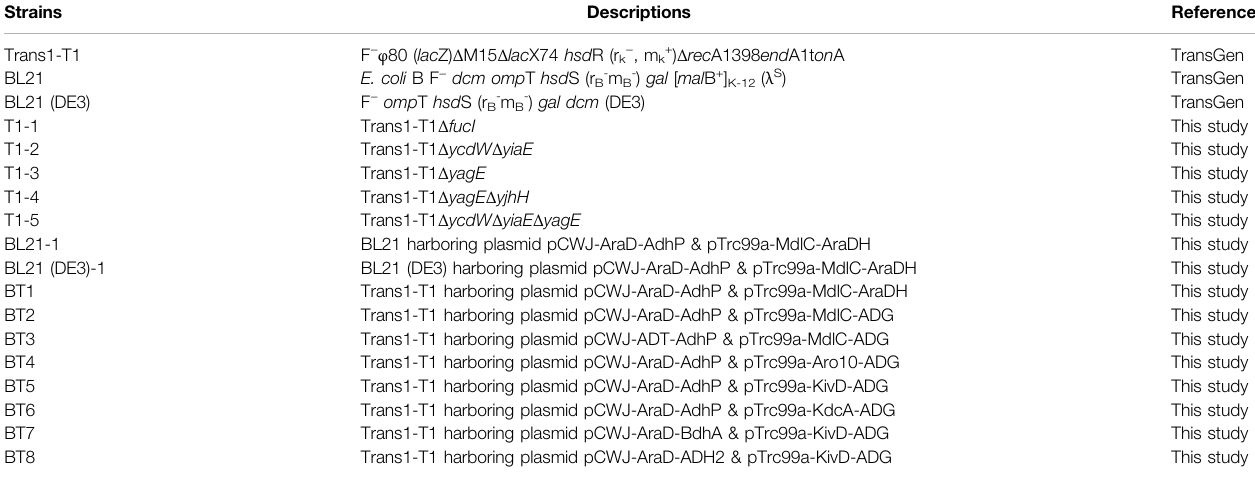
TABLE 1 | Strains used in this study.